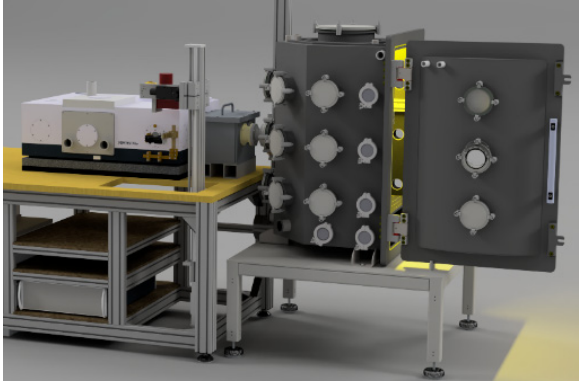
Figure 5. Improved EMMA. The vacuum vessel with the inductive heating unit on the right is at- tached to the FTIR-spectrometer on the left via the vacuum chamber in the middle. The inductor, which is used for heating the specimen and the blackbody, respec- tively, consists of a copper coil, which is internally water-cooled (see Figure 7). A high frequency alternating current induces eddy currents either inside the specimen itself or